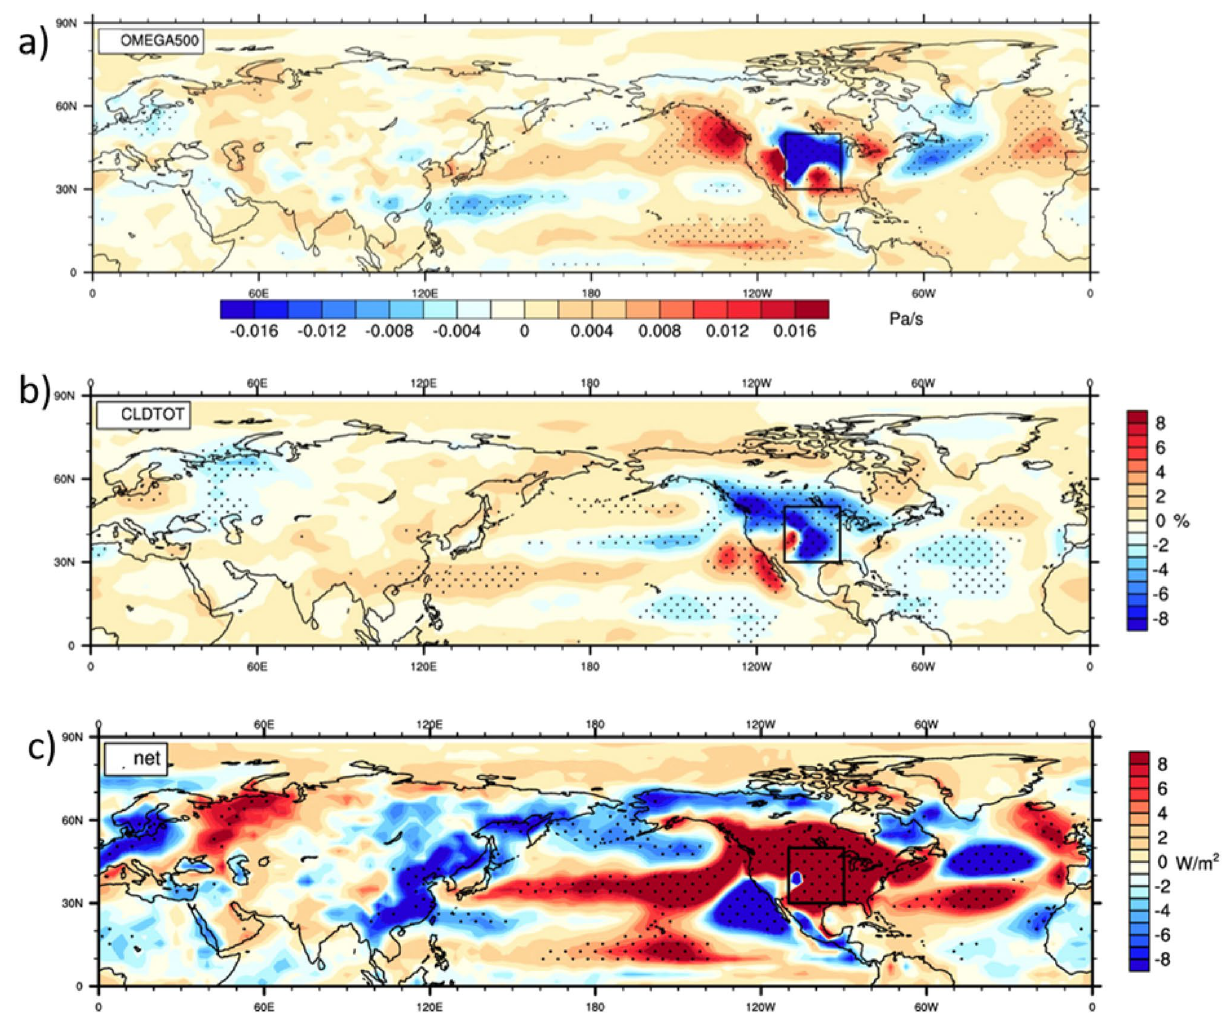
Figure 4. Processes producing far-field heat extremes. Anomalies from climate model experiment, experiment minus control, MJJA averages, stippling indicates differences significant at the 95% level; ( a ) vertical velocity at 500 hPa (Pa sec −1 ), positive values indicate anomalous downward vertical velocity; ( b ) total cloud (%), negative values indicate fewer clouds; and ( c ) net surface heat flux (W m −2 ), positive values indicate anomalous energy downward into the